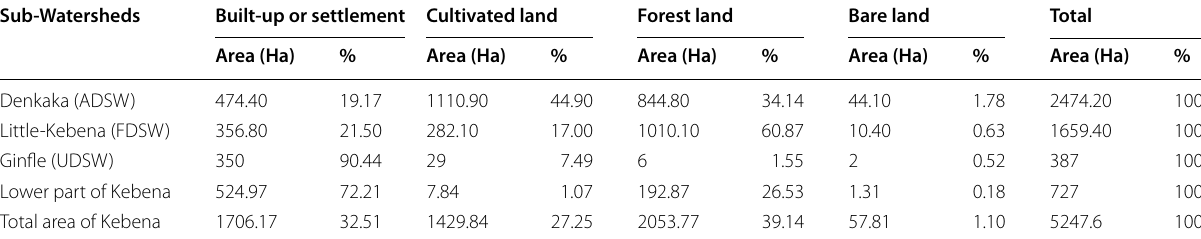
Table 1 Land use types of the three sub-watersheds (Source: Digitized from aerial photograph of 2016) Sub‑Watersheds